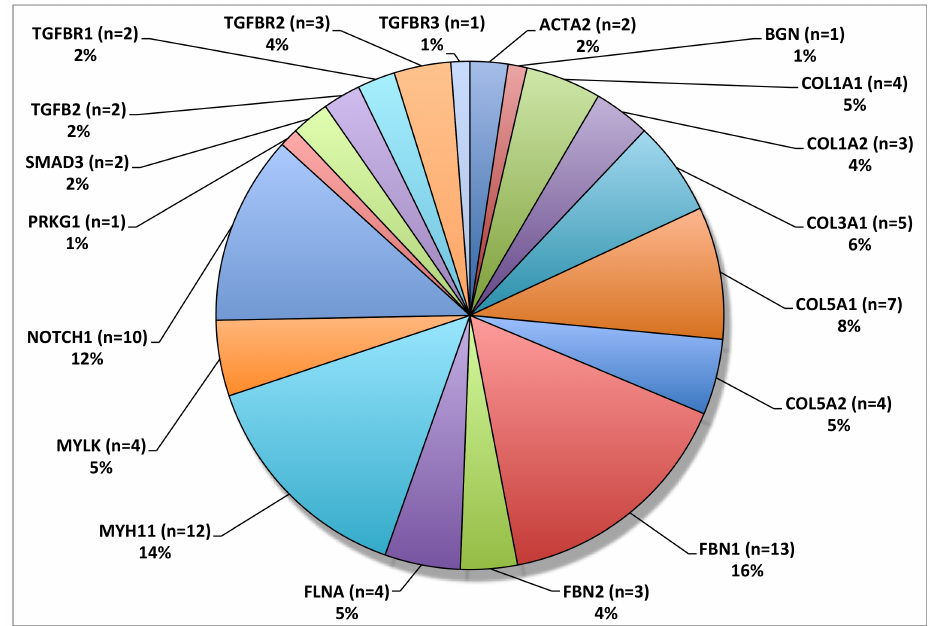
Figure 2. Overall frequency distribution of TAAD associated variants. FBN1 was the most frequently mutated gene in this patient cohort. © 2020 by Edi.Ermes.